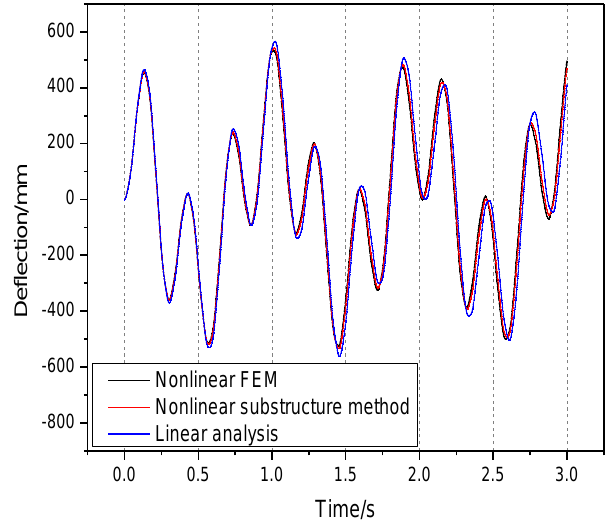
20N F  and 1Hz f  . 0